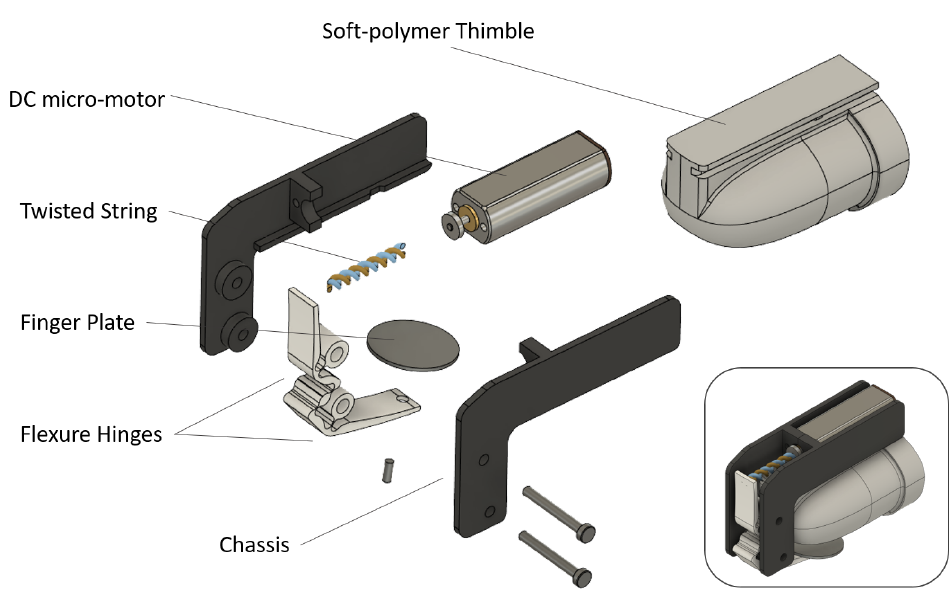
Figure 10. Exploded view of the final device implementation: it evidences how the twisted string and flexure hinges approach minimizes complexity and number of parts